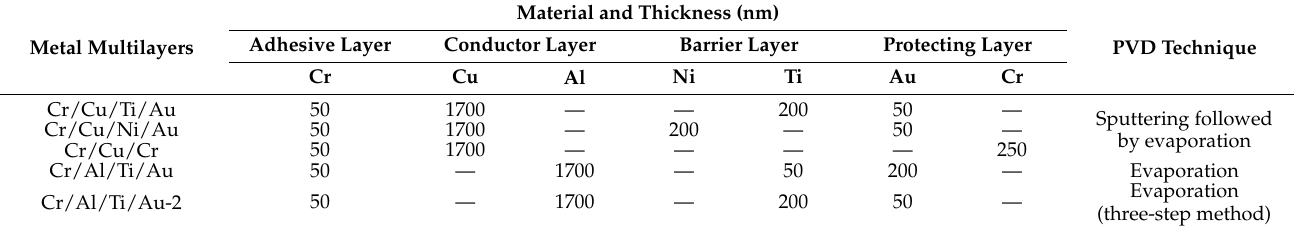
Table 1. Details about materials, thickness and deposition techniques of metal multilayers.